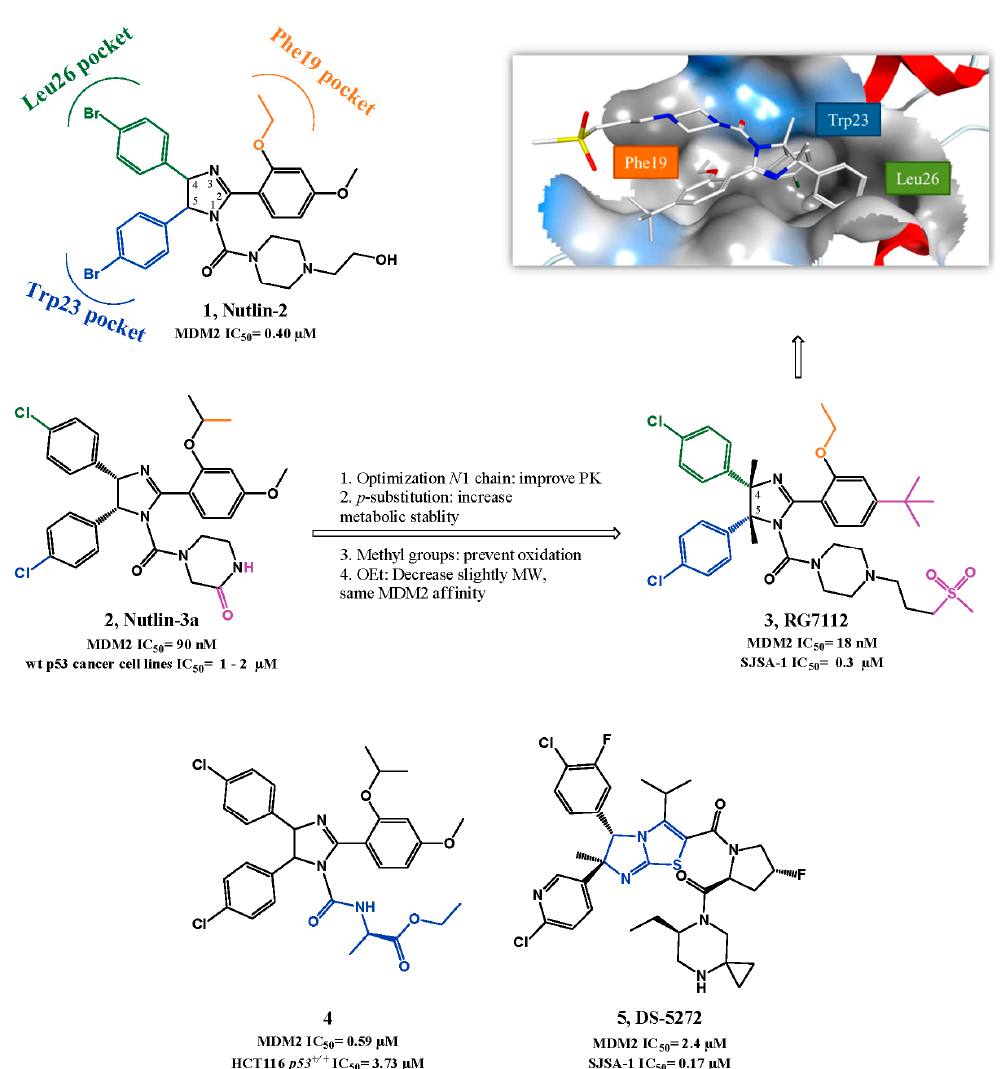
Figure 2. Nutlin scaffold optimization and examples of nutlin derivatizations. Right upper quadrant: crystal structure of compound 3 bound to MDM2 (PDB 4IPF). MDM2 surface is colored in blue for hydrophilic areas and grey for hydrophobic areas. Compound 3 is depicted in stick model and is colored according to element type: white for carbon atoms, blue for nitrogen atoms, red for oxygen atoms, yellow for the sulfur atom, and green for chlorine atoms.